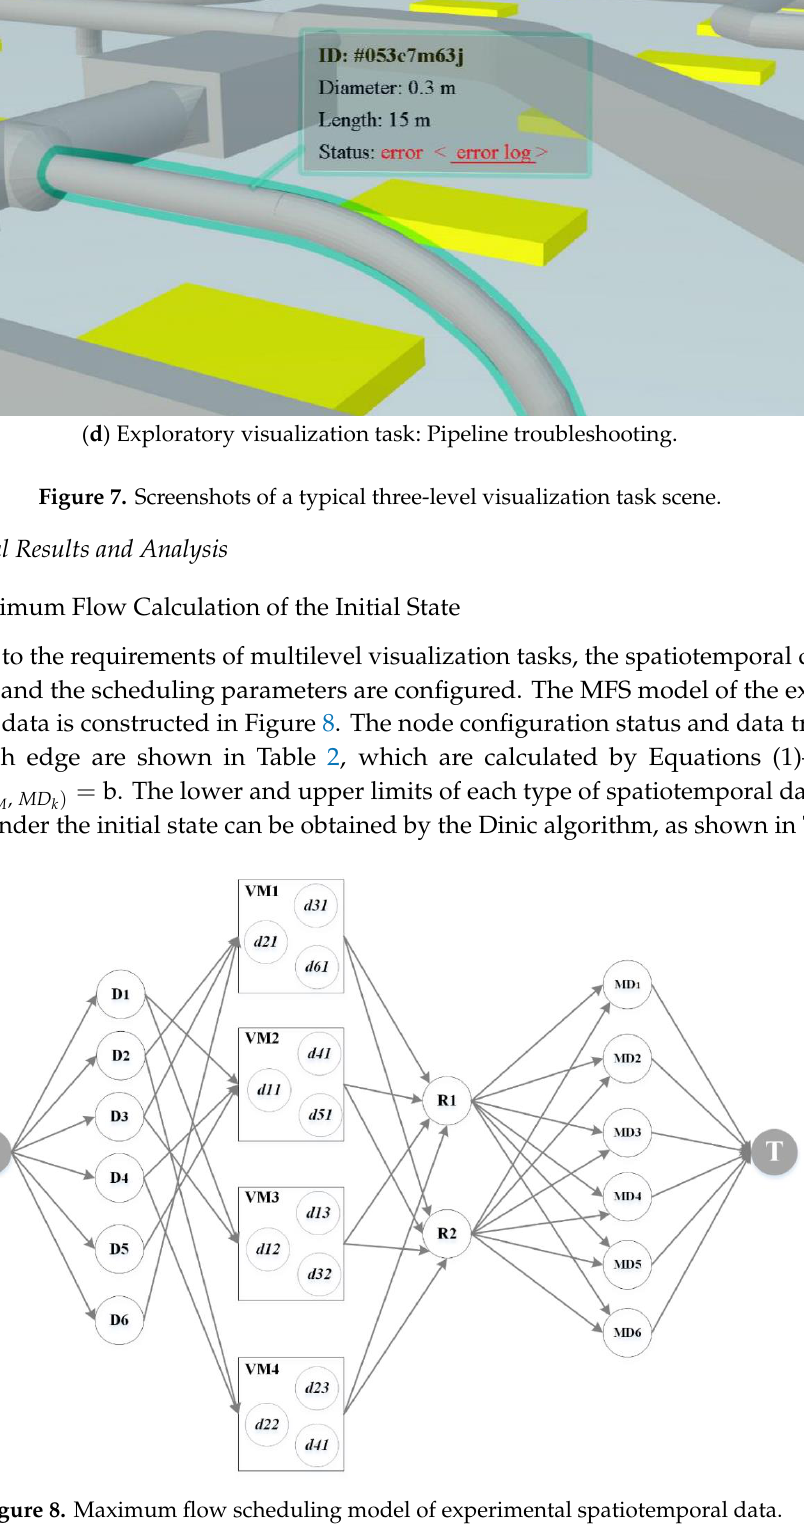
Figure 8. Maximum flow scheduling model of experimental spatiotemporal data.